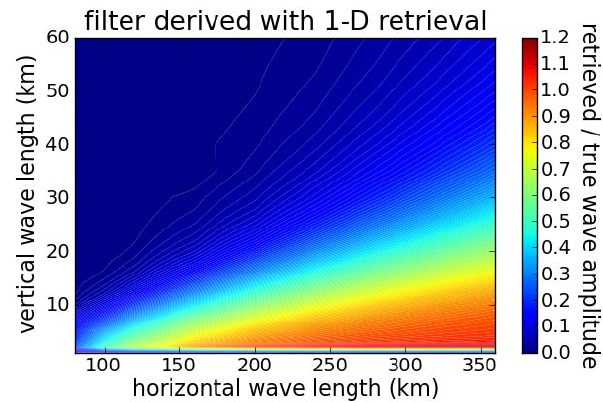
Fig. 14. This depicts the gravity wave observational filter derived by a series of a 1-D